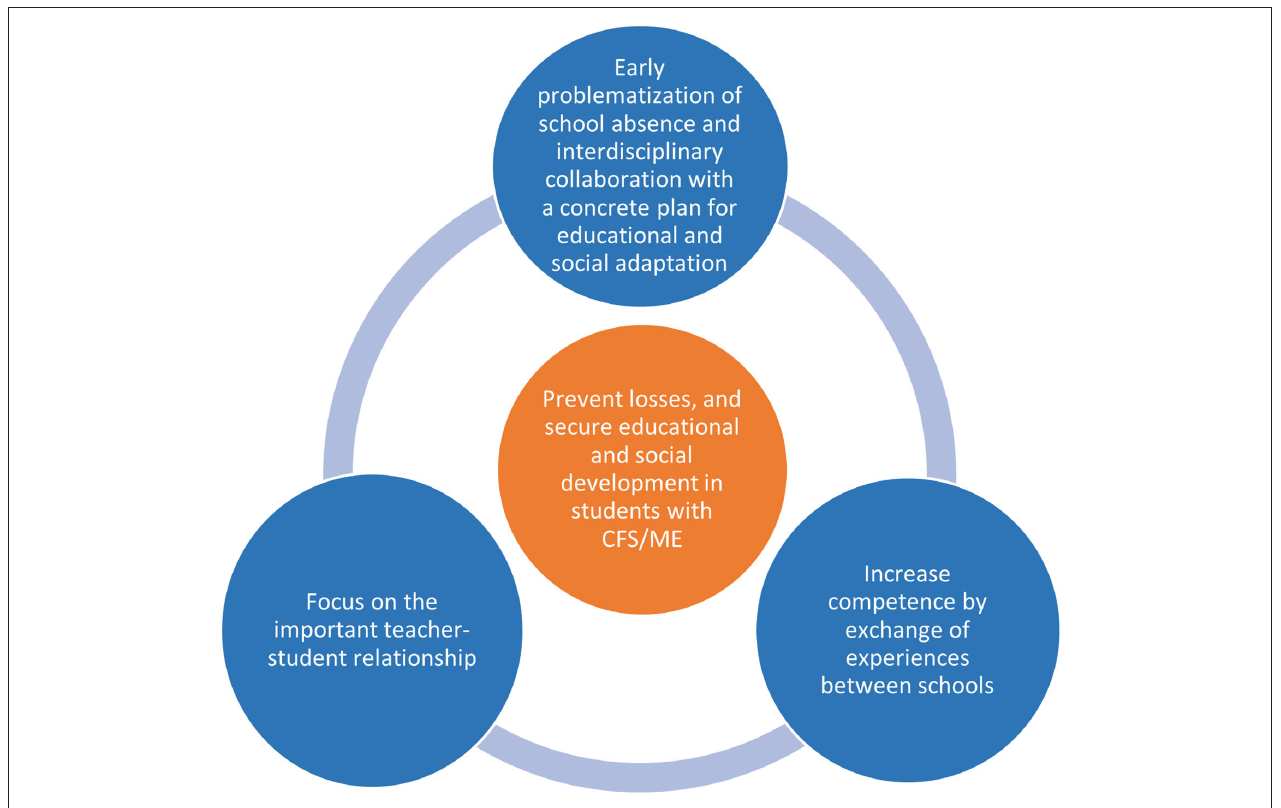
FIGURE 1 | Suggestions for successful educational adaptations and prevention of losses for students with